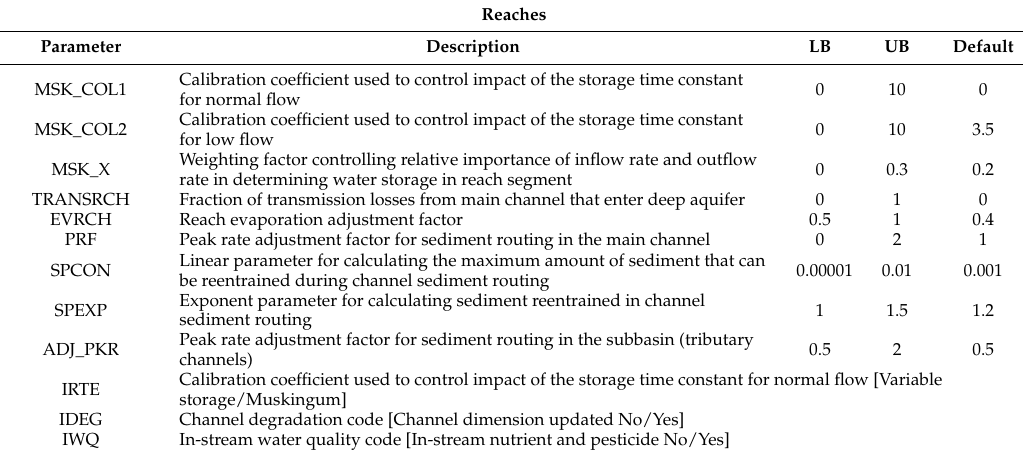
Table A4. Adjustable SWAT parameters for functions within